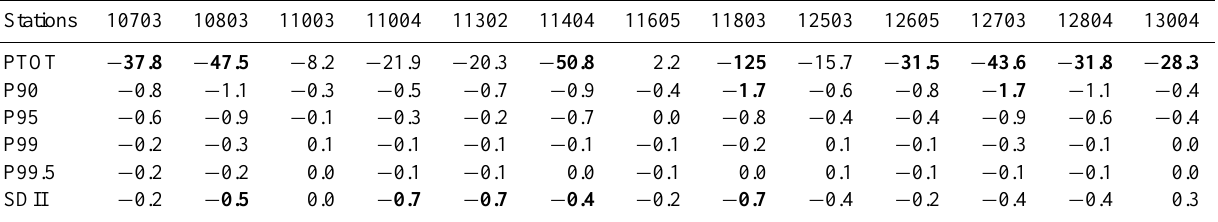
Tableau 2. Tendance des indices de pluie journalière par décennie (PTOT: mm/décennie, fréquence: jours/décennie, SDII: mm/jour/décennie) (valeurs significatives en gras au niveau 5%). Stations